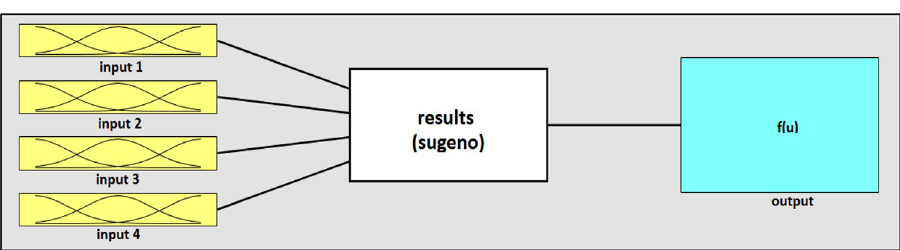
Fig 4. ANFIS system results with four input parameters, three rules, and one output, (generated from MATLAB